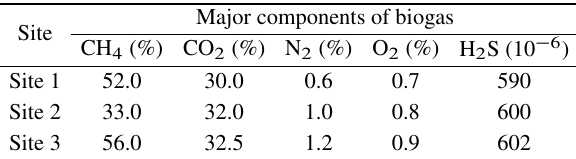
Fig. 5 Characterization of Mohammedia landfill biogas. Table 1 Variation in the composition of biogas in the